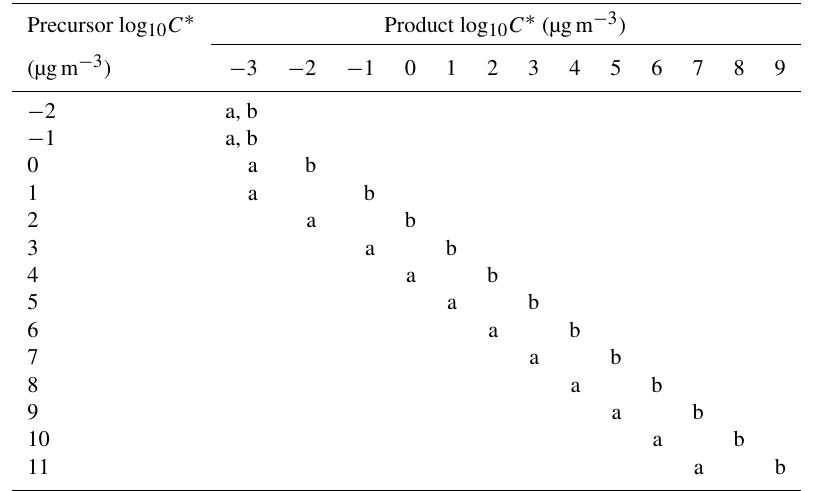
Table 2. Gas-phase chemistry volatility matrix that describes the change in volatility of the gas-phase organics after a single reaction with OH. Labels a and b represent the cases with four- and two-volatility-bin drops per reaction,